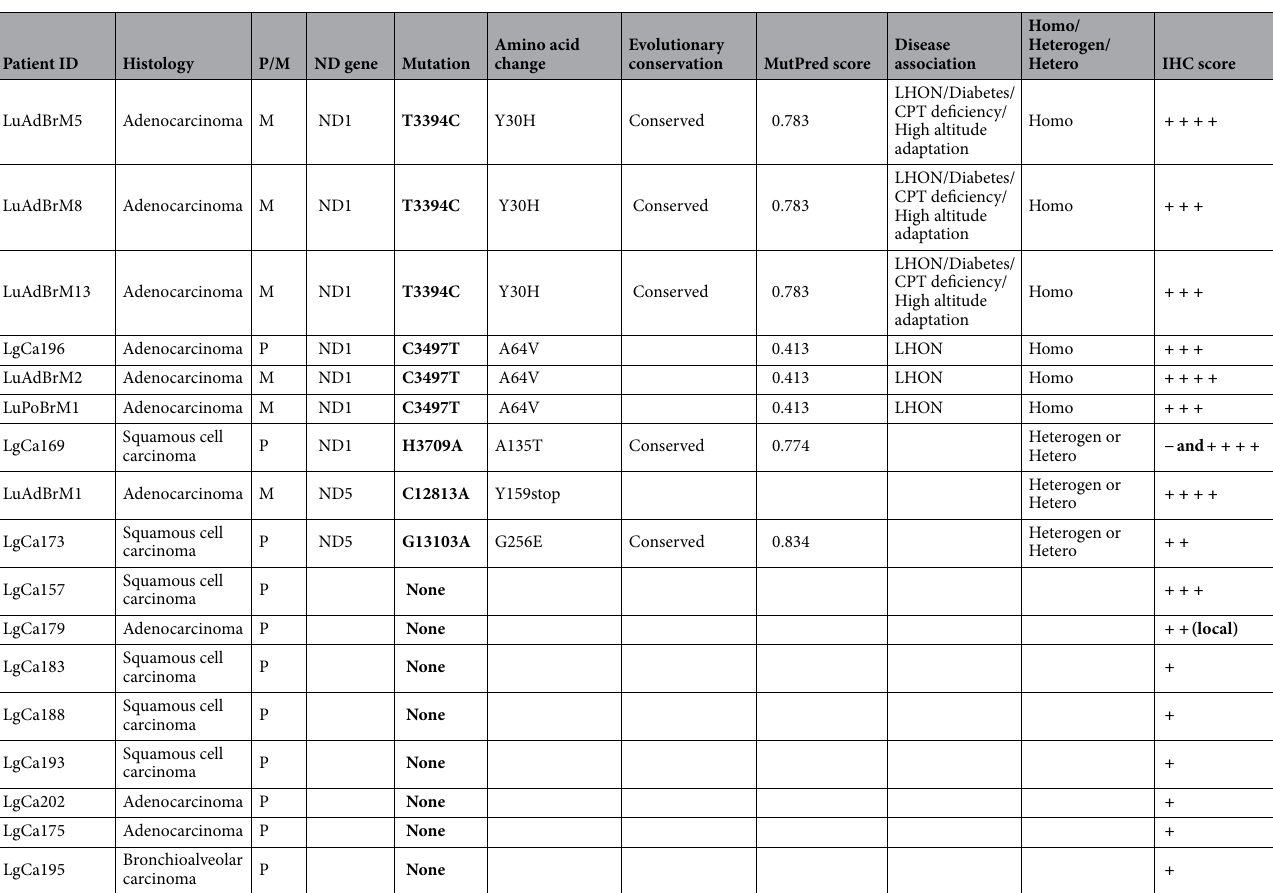
Table 2. MCT4 expression in NSCLC tissues with or without predicted pathogenic mutations. Homo/ Heterogen/Hetero: Homoplasmy/Heterogeneous/Heteroplasmy. Heterogeneous means a mixture of cancer cells with the mutation, those without the mutation and/or host-derived stromal cells with wild-type mtDNA. P/M, Primary